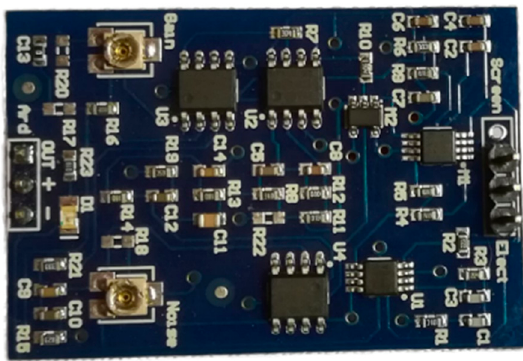
Figure 2. The Bitronics EEG module.